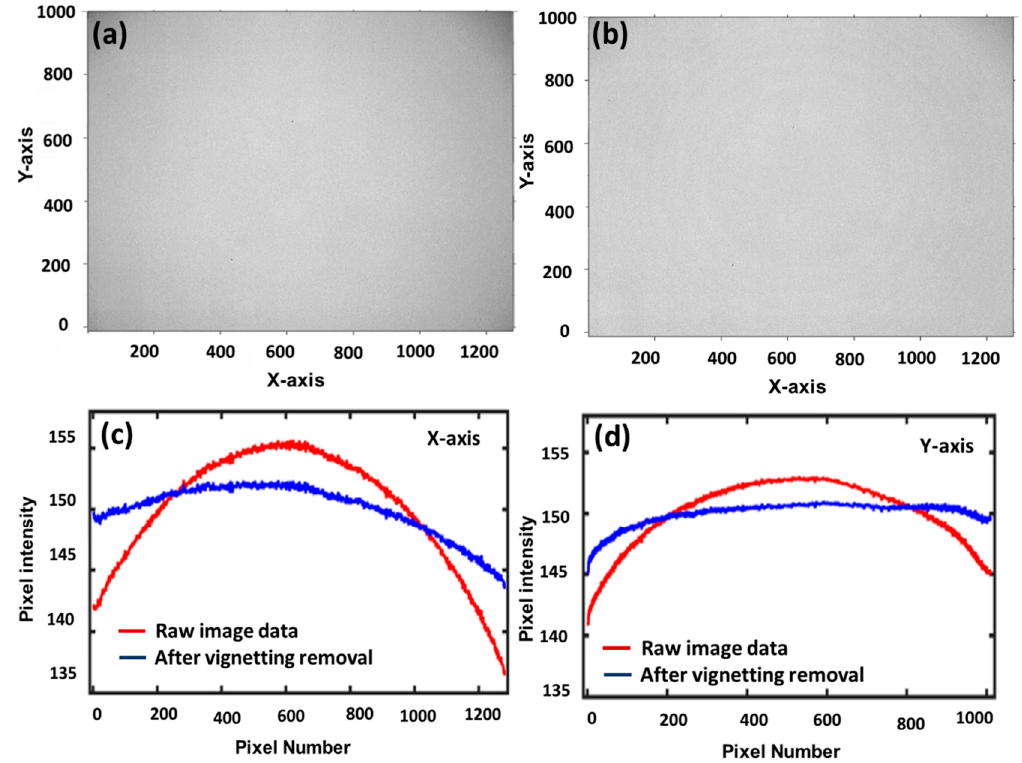
Figure 4. Vignetting e ff ect and removal for images. ( a ) Raw image of white reference shows high intensity at the center and dark corners are seen clearly; ( b ) Corrected image shows almost uniform intensity; ( c ) Intensity corrected for X-axis; ( d ) Intensity corrected for Y-axis.